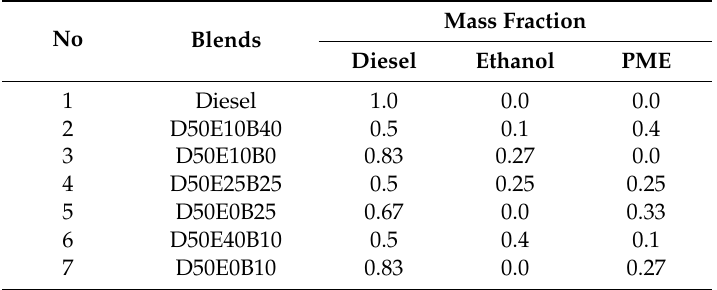
Table 3. Blend composition. D50E10B40: 50% diesel, 10% ethanol, and 40% PME,